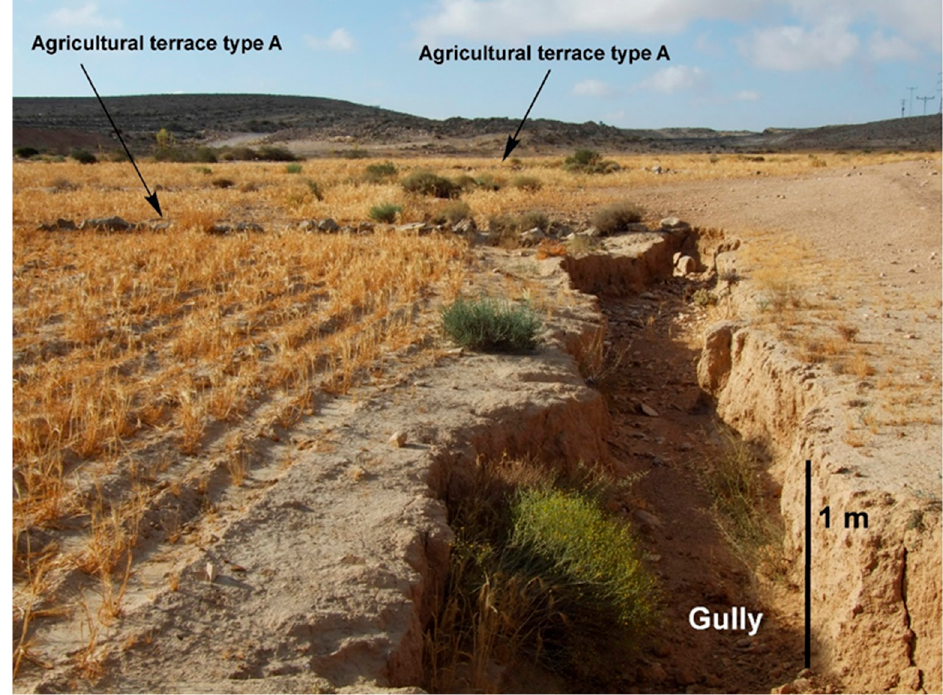
Figure 12. Gully developed within an agricultural plot, dissecting Type A terraces. Negev Highlands. (Photograph: Y. Avni).